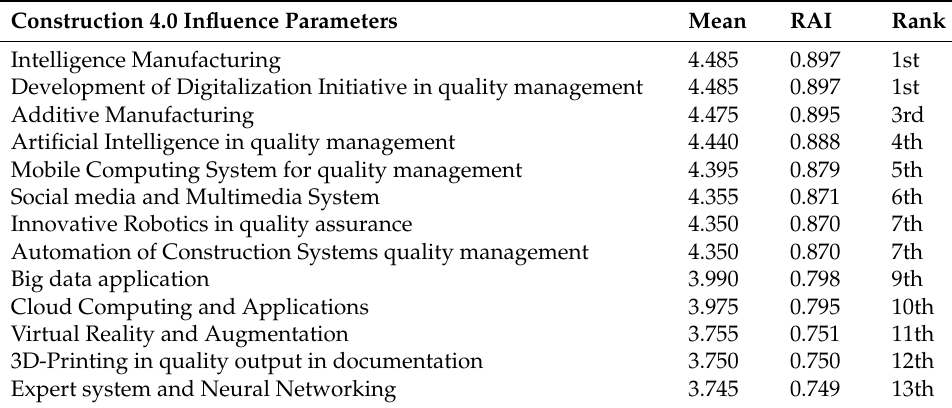
Table 3. Influence of Construction 4.0 on quality